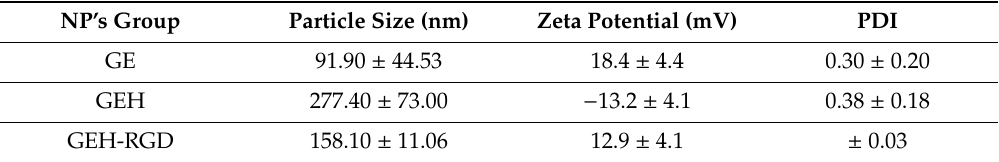
Table 1. Characterization of variant NPs.